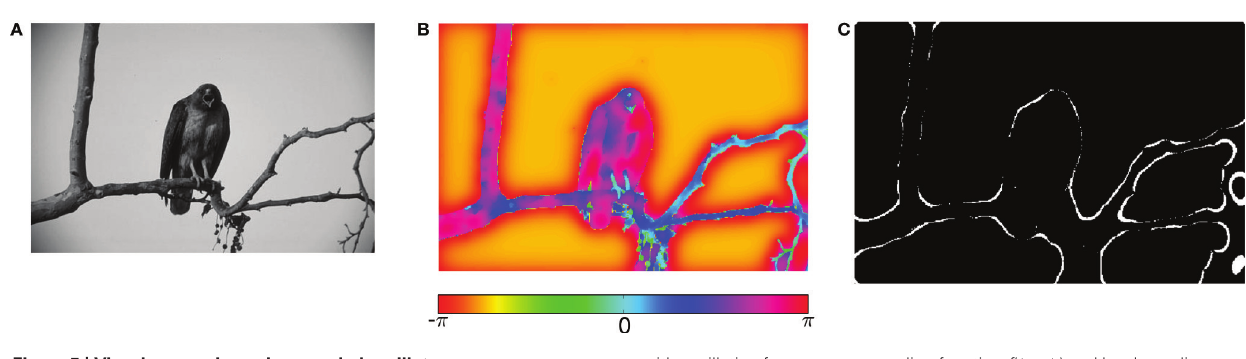
Figure 5 | Visual processing using coupled oscillators. (A) Example image from the Berkeley segmentation database. (B) Phase representation in network of coupled phase oscillators φ ( x ) evolving according to the dynamic equation